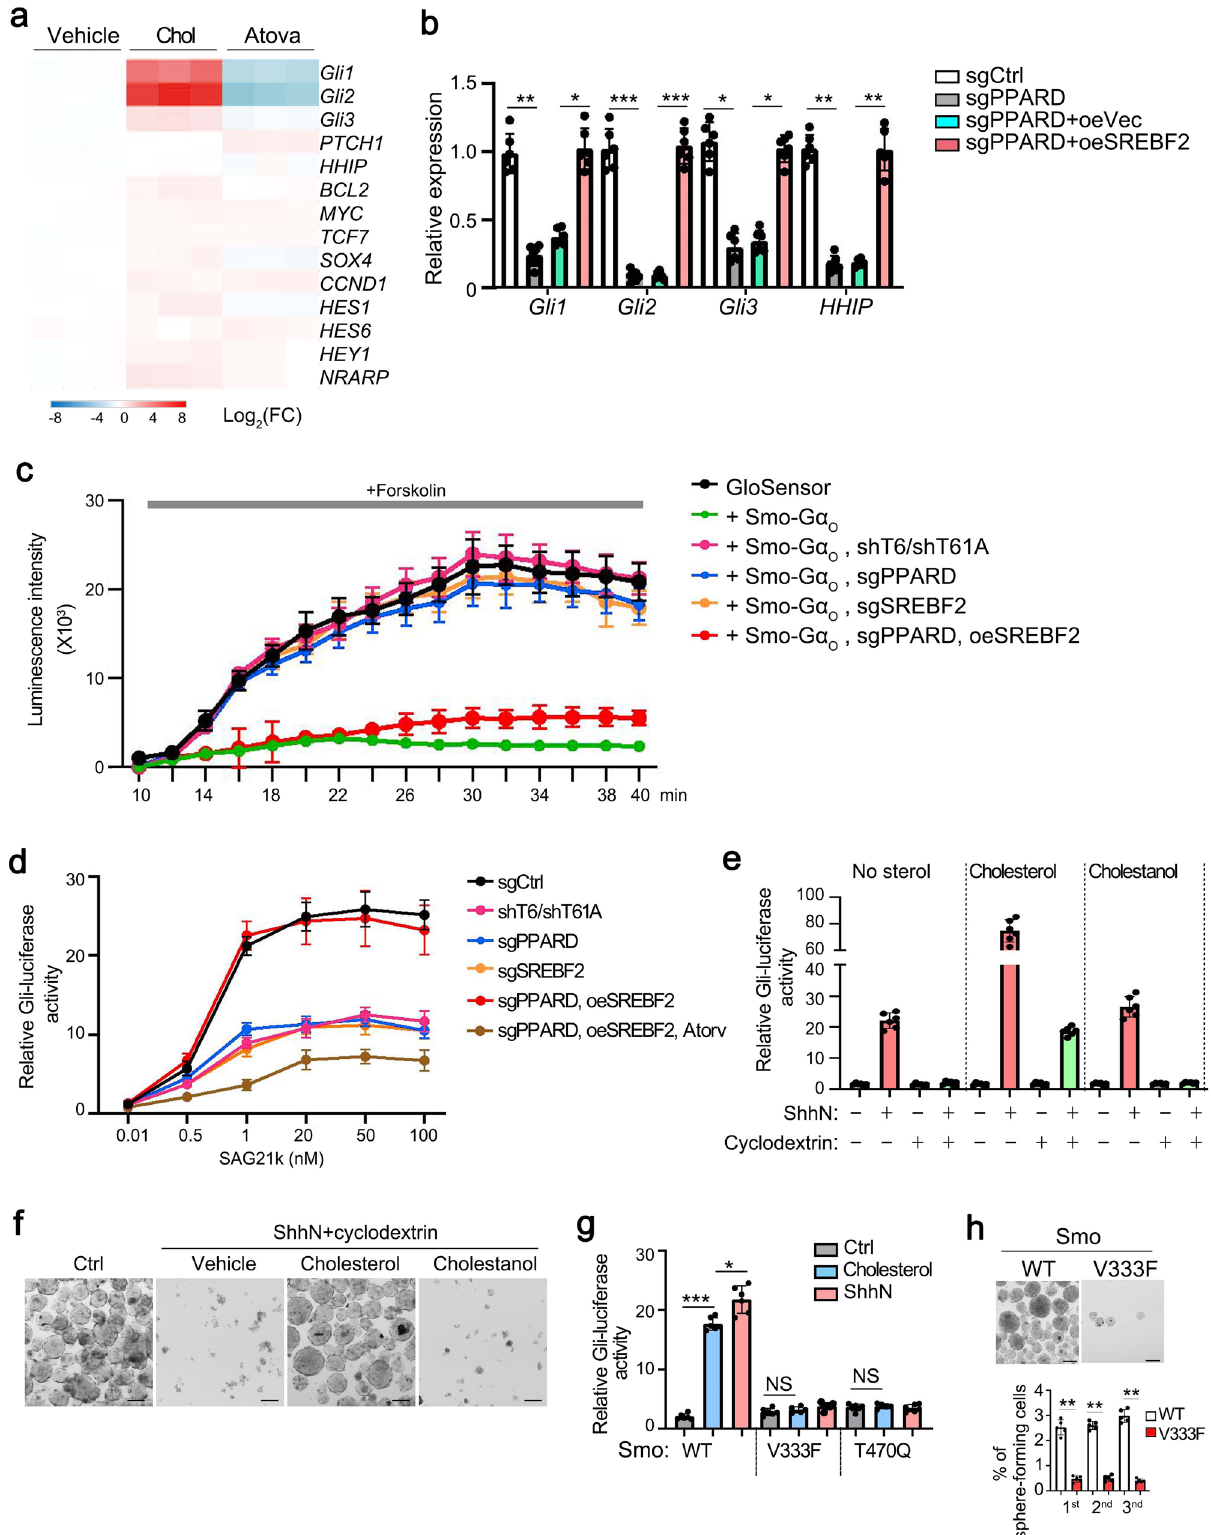
PDC cells compared with GSK3787 alone. Importantly, combi- nation of thiram with PPAR δ antagonist GSK3787 had synergic effect on tumor suppression (Fig. 7c). Atorvastatin treatment also decreased xenograft tumor growth (Fig. 7d). Thiram and GSK3787 combination signi fi cantly increased mouse survival